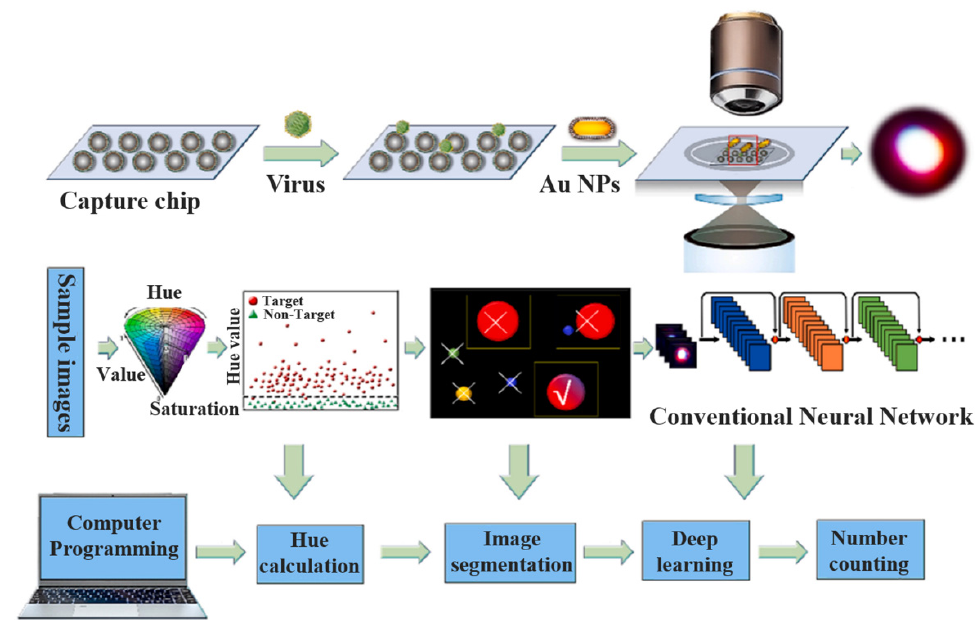
Figure 4. Working principle of the AI-assisted enumeration of ultra-small EV71 virus with two plas- mon resonance probes under DFM. Reprinted with permission from [32]. Copyright 2022 Elsevier.